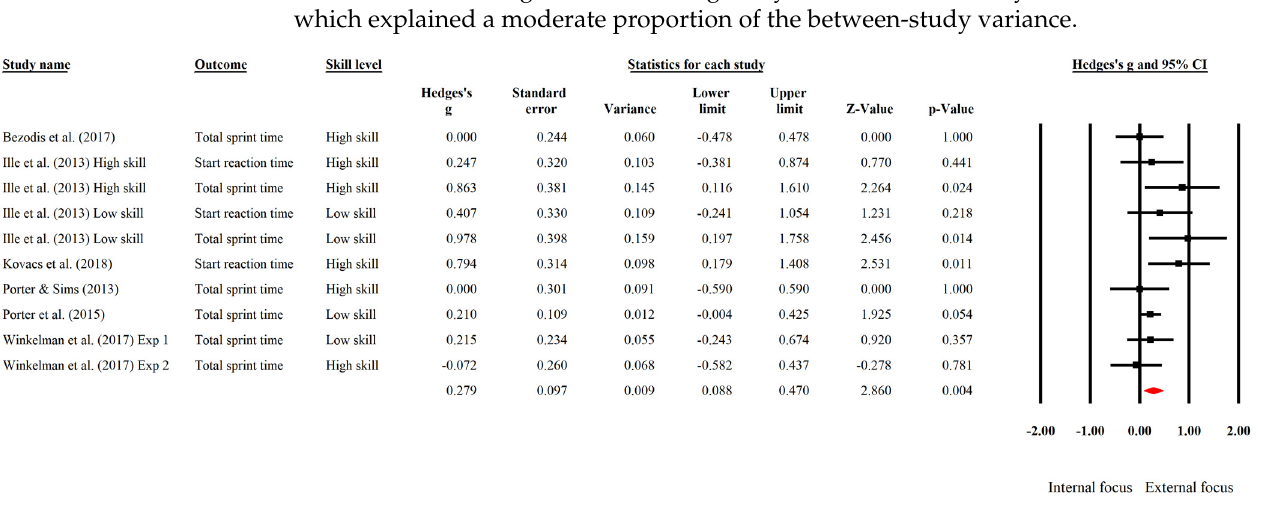
Figure 2. Forest plot of effect sizes in sprint performance studies comparing external focus versus internal focus [18,19,50–53].